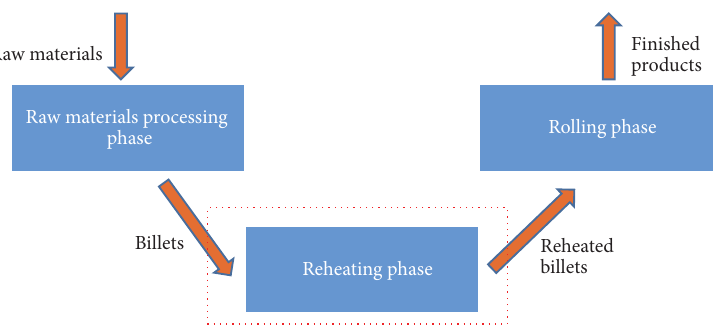
Figure 1: Workflow of the considered Italian steel industry.